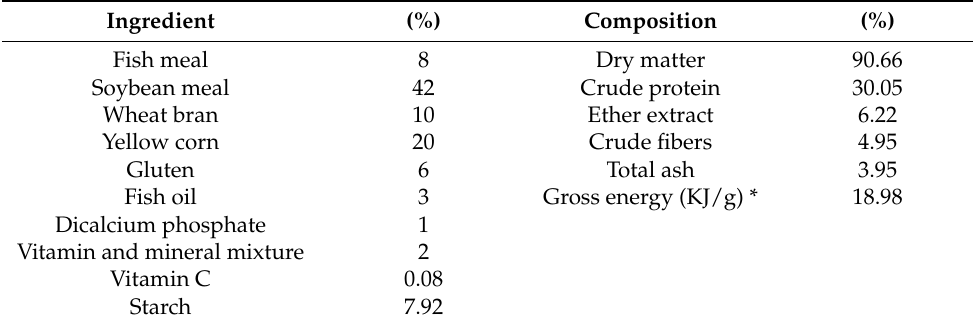
Table 1. Basal diet formulation and chemical